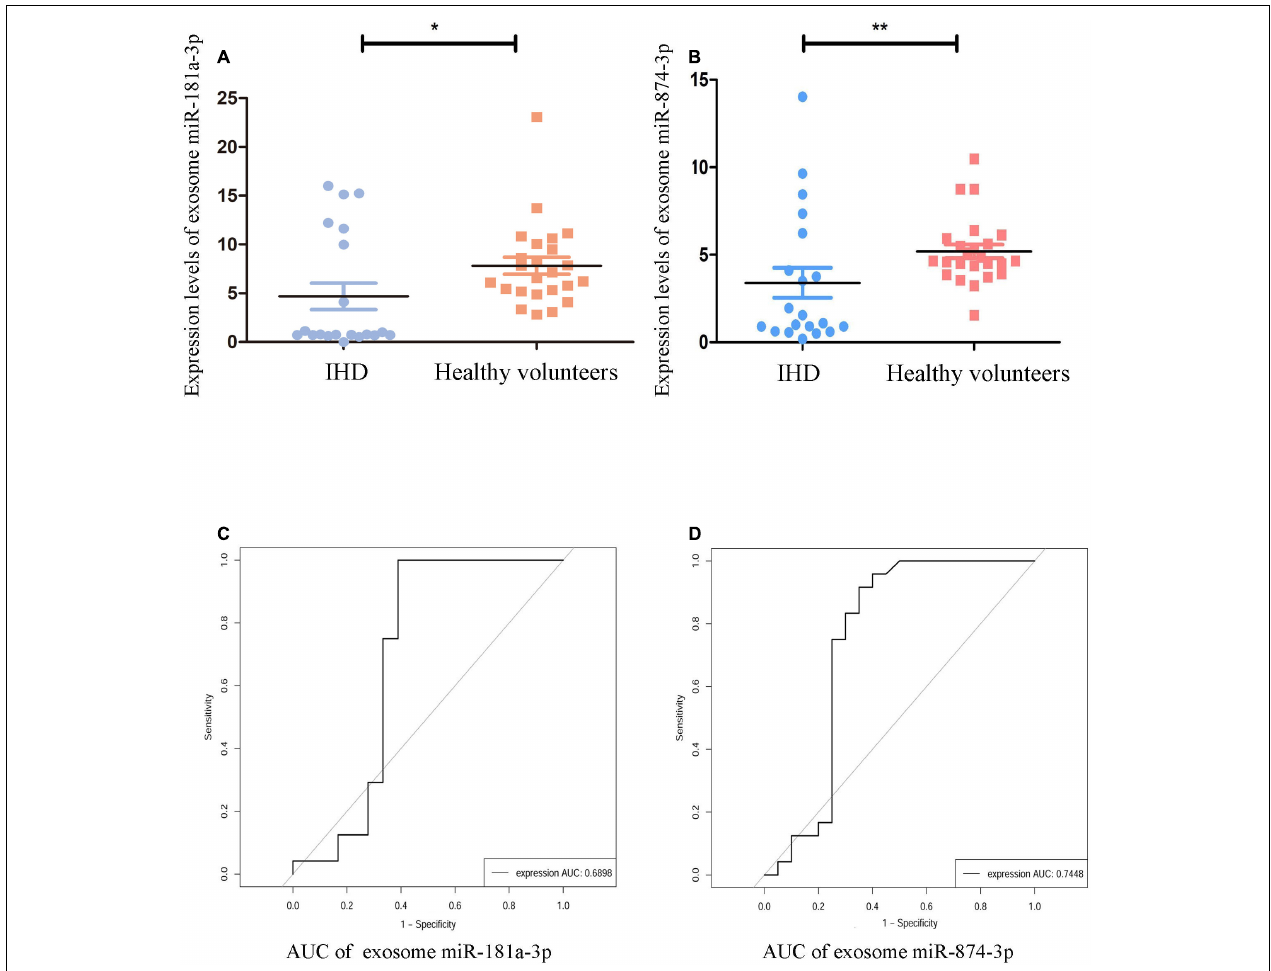
FIGURE 4 | Validation of specific exosomal miRNAs. The validation group comprised 20 patients with STEMI and 24 healthy volunteers. The relative expression levels of exosome miRNAs were normalized to levels of U6. (A) Compared to healthy volunteers ( n = 24), expression of hsa-miR-181a-3p was significantly reduced in patients with STEMI [ischemic heart disease (IHD), n = 20] and was normalized to levels of U6 using quantitative PCR (qPCR), ** p < 0.01. (B) Compared to healthy volunteers ( n = 24), expression of hsa-miR-874-3p was significantly lowered in patients with STEMI (IHD, n = 20) and was normalized to levels of U6 using qPCR, ** p < 0.01. (C) The receiver operating characteristic (ROC) curve of hsa-miR-181a-3p. (D) The ROC curve of hsa-miR-874-3p. * p <